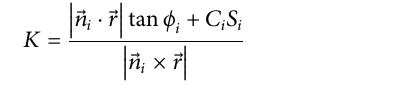
Frontiers in Earth Science |